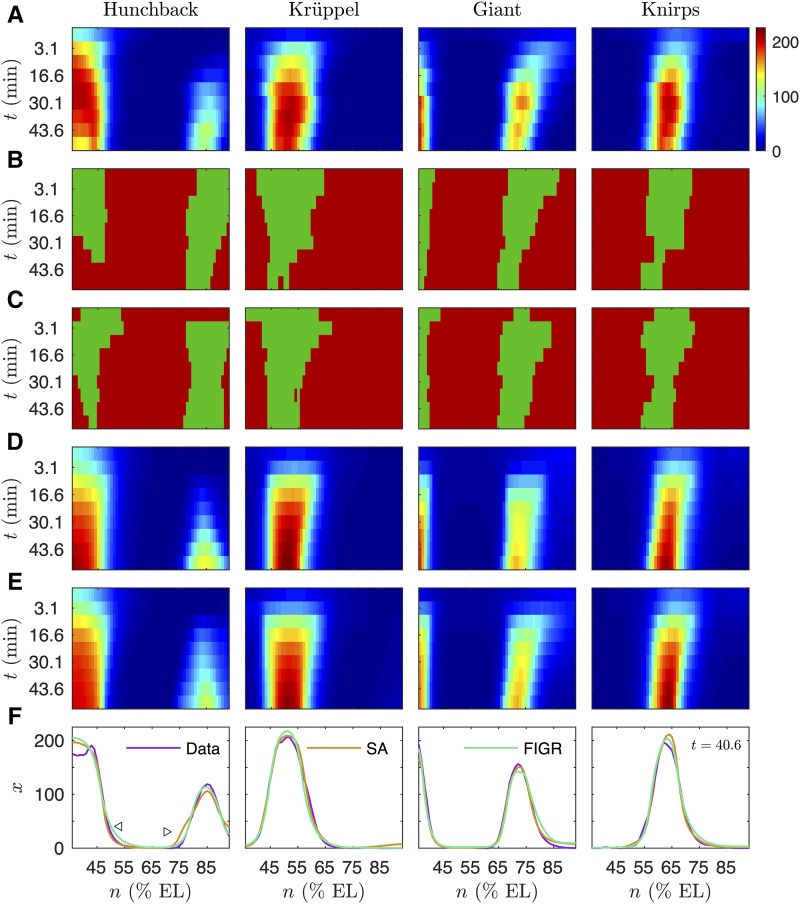
Classification-based inference of the Drosophila gap gene network. Horizontal axes indicate anteroposterior position. Vertical axes represent time elapsed since the thirteenth nuclear division in the downward direction. A. Integrated spatiotemporal gap gene expression data xng(tk), where k=1,…,9, used to infer the gene circuit. Data at the first time point are from cycle 13 and serve as initial conditions for the model. The rest of the time points correspond to eight time classes in cycle 14 separated by 6.25 min. Hot (cold) colors indicate high (low) expression levels. B. Classification of ON/OFF state. Green (red) colors indicate ON (OFF) states yng(tk) determined from velocities vng(tk). C. Prediction of ON/OFF state y∼ng(tk) using parameter values inferred with FIGR. D. Gene circuit output using parameters obtained by FIGR and then refined using local search (RMS = 13.29). E. Gene circuit output using parameters inferred by SA (RMS = 11.03). F. Comparison of the spatial patterns of gap gene expression (blue), output of gene circuit inferred by SA (red; SA), and output of gene circuit inferred by FIGR (green) at t=40.6 min (time class T7). Slightly shallow posterior border of the anterior Hb domain in FIGR output is indicated with ◁. Slight ectopic bump in the anterior border of the posterior Hb domain in SA output is indicated with ▷.